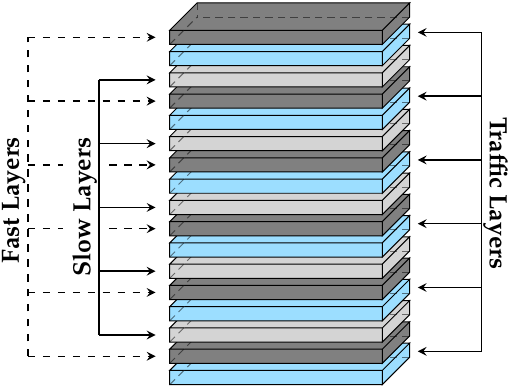
Figure 6. Different altitude layers used in this